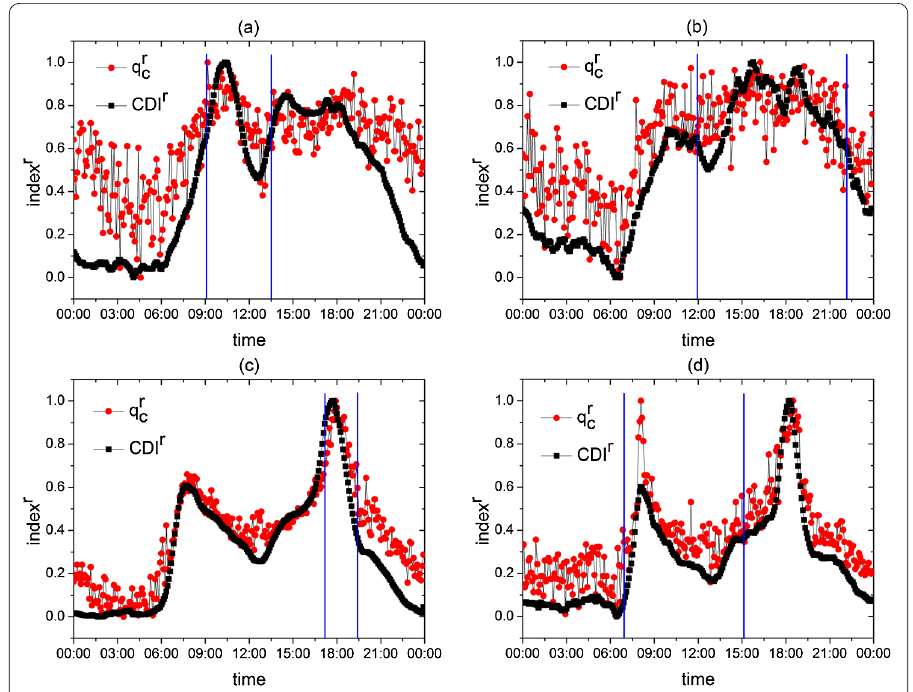
Figure 5 Different behaviors of q r c and CDI r during the same time period. (a) q r c and CDI r as a function of time in Beijing on Oct. 1st, Thursday. (b) q r c and CDI r as a function of time in Shenzhen on Oct. 1st, Thursday. Blue lines in (a) and (b) mark the two instants when CDI r stays almost the same while q r c changes obviously. (c) q r c and CDI r as a function of time in Beijing on Oct. 28th, Wednesday. (d) q r c and CDI r as a function of time in Shenzhen on Oct. 28th, Wednesday. Blue lines in (c) and (d) mark the two instants when q r c stays similar, while CDI r changes